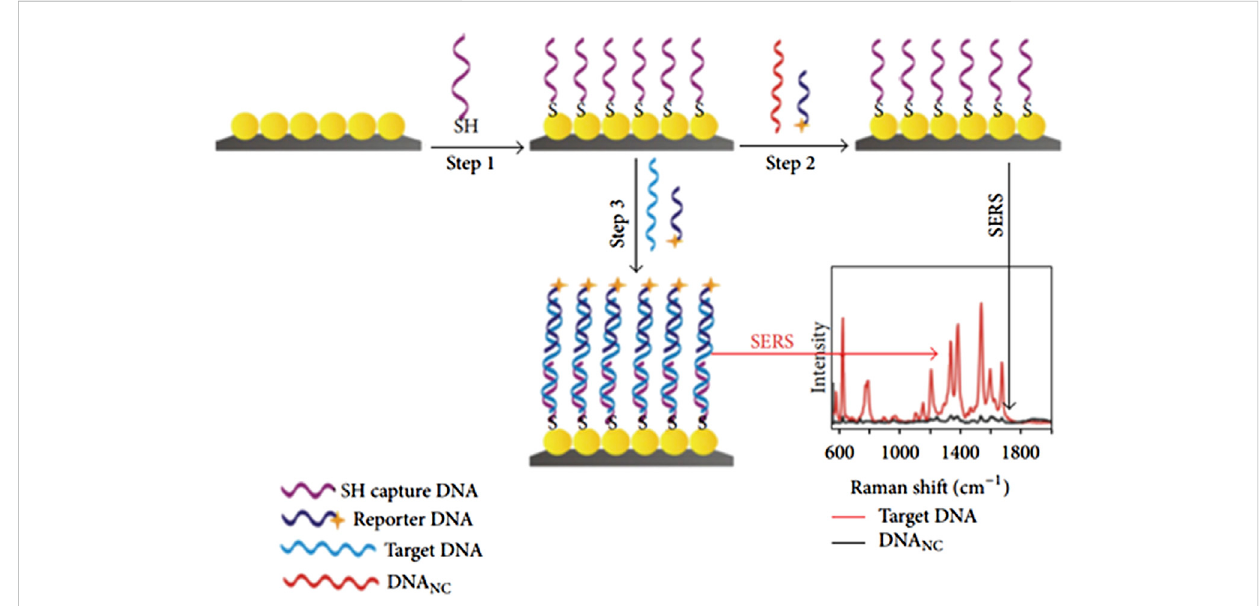
Schematic of the fabrication route for SERS sensor and variation of Raman shift as a function of intensity (Jiang et al., 2012).